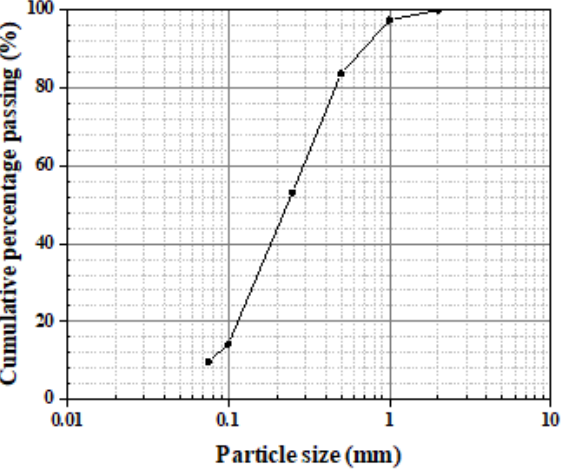
Figure 1. Frequency distribution curve of laser particle size of tailings. Table 1. Chemical composition of tailings.